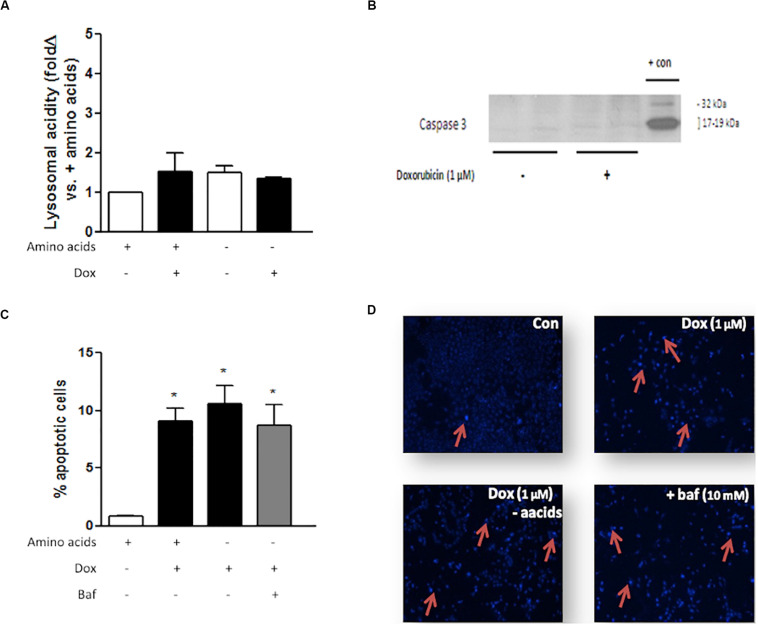
The effect of amino acid starvation, autophagy inhibition and Dox treatment in beclin 1-haploinsufficient MCF7 cells. (A) Lysosomal acidity in amino acid-starved MCF7 cells following Dox treatment. (B) Representative western blot showing lack of caspase 3 expression in MCF7 cells. (C) Bar graph indicating the percentage of nuclei that represents morphological changes characteristic of apoptosis in MCF7 cells following Dox treatment and Baf-mediated autophagy inhibition and (D) representative images of MCF7 cells stained with Hoechst. Red arrows demonstrate apoptotic nuclear features. Images were obtained using a 10× objective. Each value represents the mean ± SEM of at least three independent determinations. + con, positive control; con, control; aacids, amino acids; *p < 0.05 vs. amino acid control.